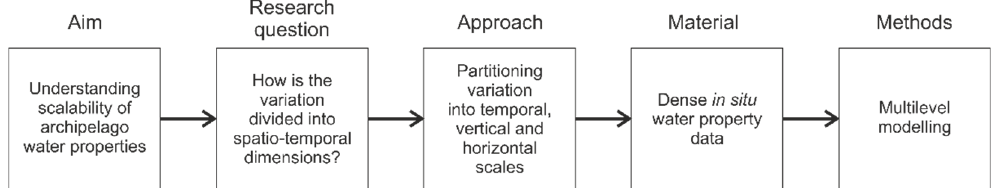
Figure 1. Graphical workflow of the aims and approach of this